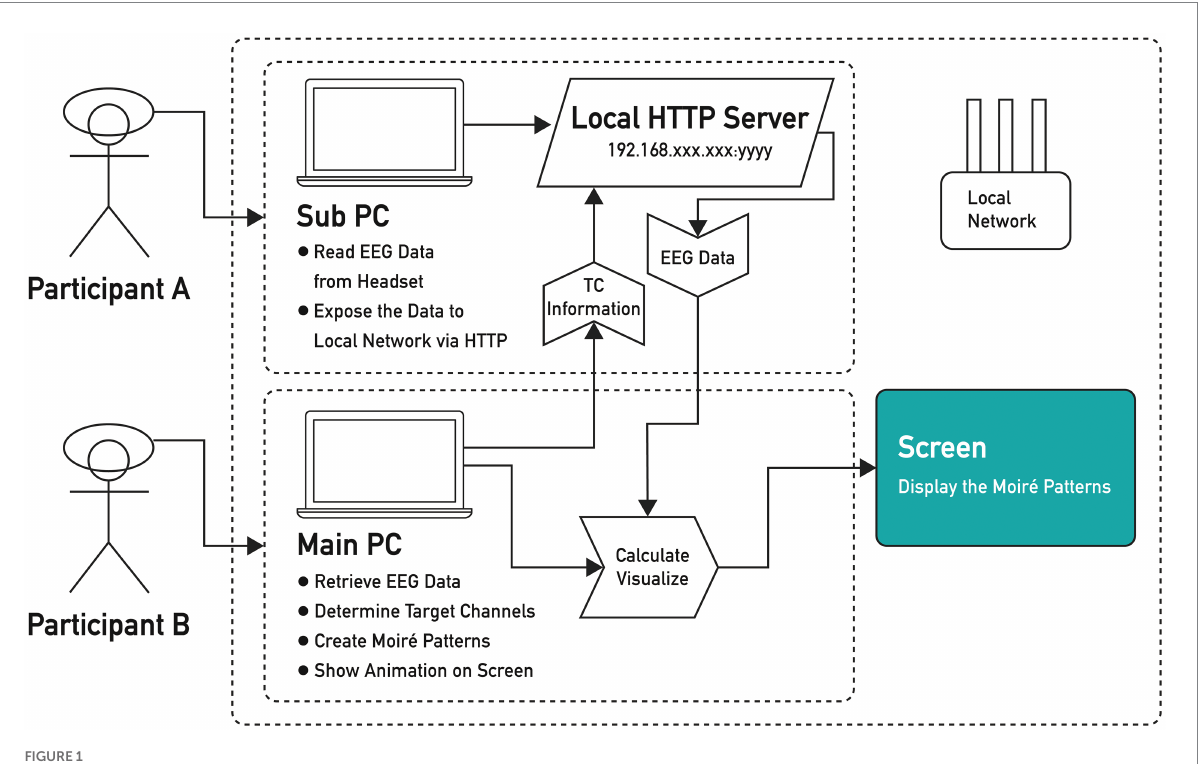
FIGURE 1 Flowchart of the operation of the experimental